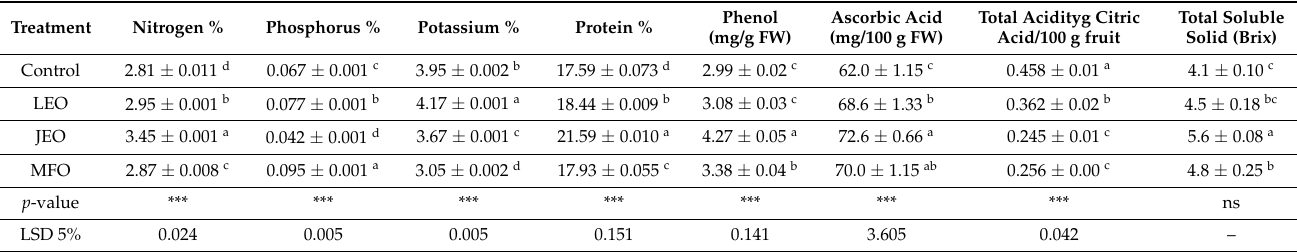
Table 6. The effect of foliar application with jasmine and lavender essential oils or mustard fixed oil on eggplant fruit quality under TSSM natural infestation in a controlled